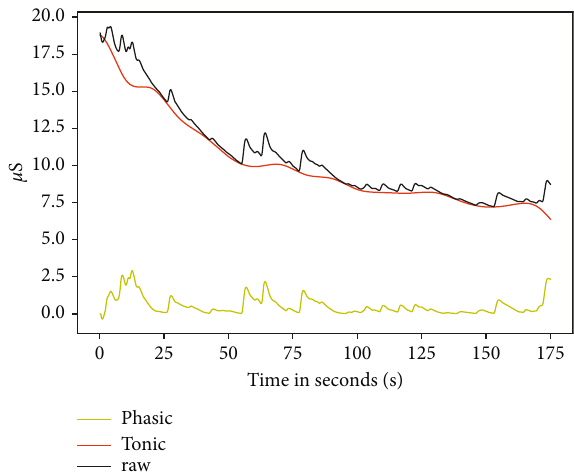
Figure 4: Representation of the EDA of the selected person before (raw) and after separation into phasic and tonic data (density 8 p/ m 2